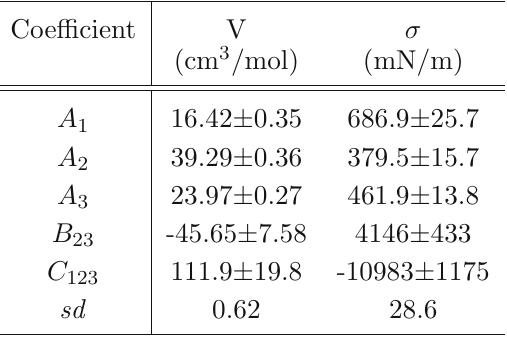
Table 6 Coefficients A fit in the system CaO-Fe 2 O 3 -Cu 2 O at the temperature of 1573